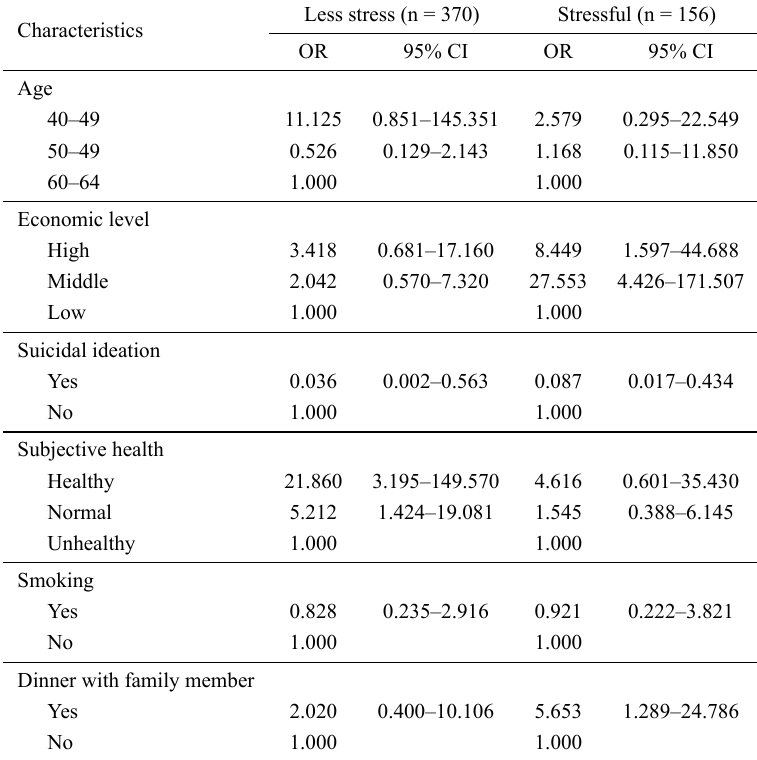
Table 4. Factors related to HRQoL according to stress level (n =